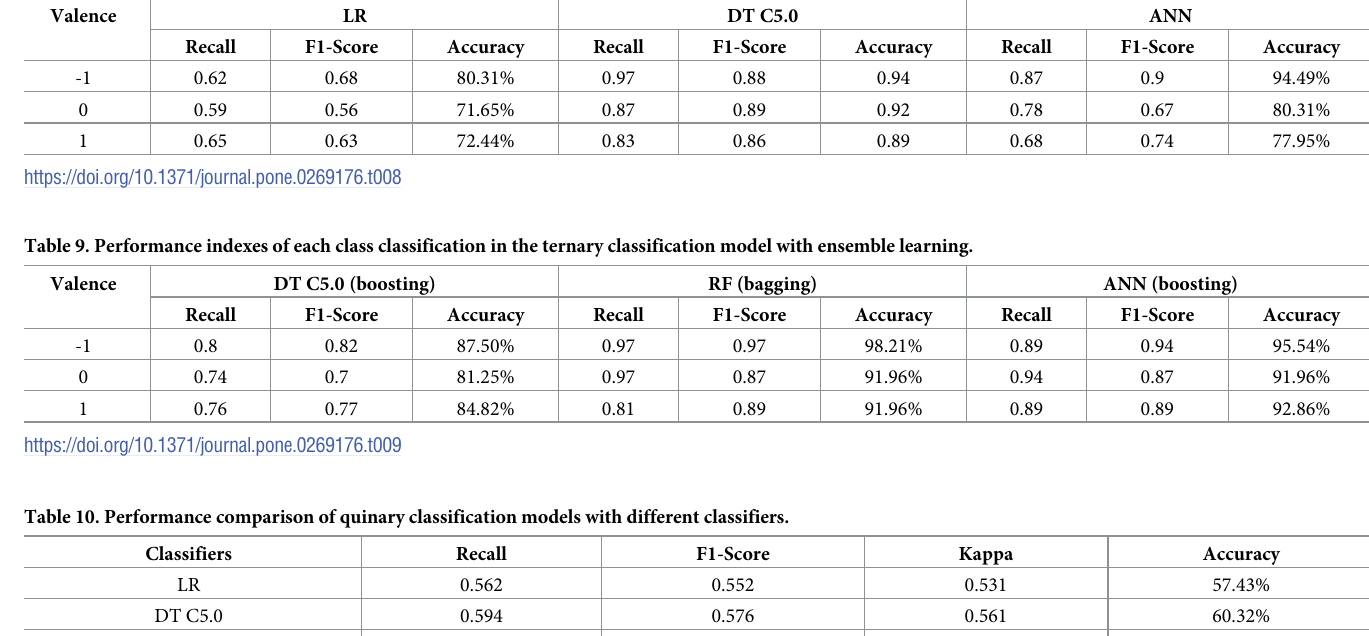
Table 8. Performance indexes of each class classification in the ternary classification model with three single classifiers.